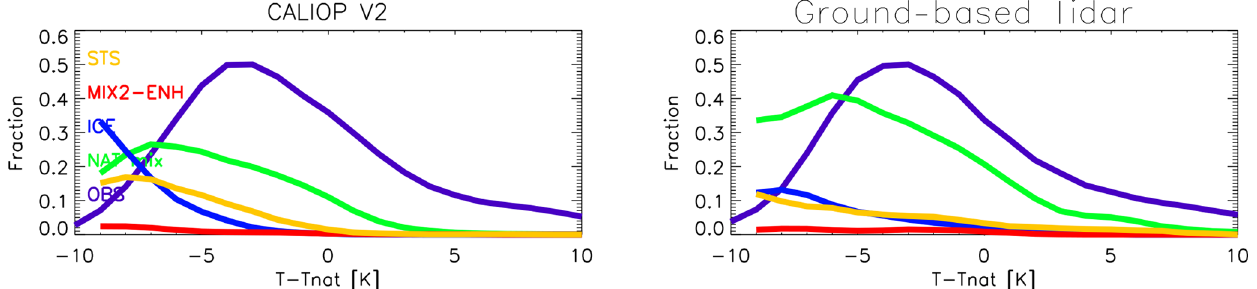
Figure 4. Fraction of PSC observations in 2006–2010 centered at McMurdo (calculated as the ratio of the number of data points for each PSC class and the total number of data points) as a function of the difference between the temperature and the equilibrium temperature for NAT. PSC classes are reported in different colors. The purple line indicates the total number of observations (in arbitrary units) at a specific